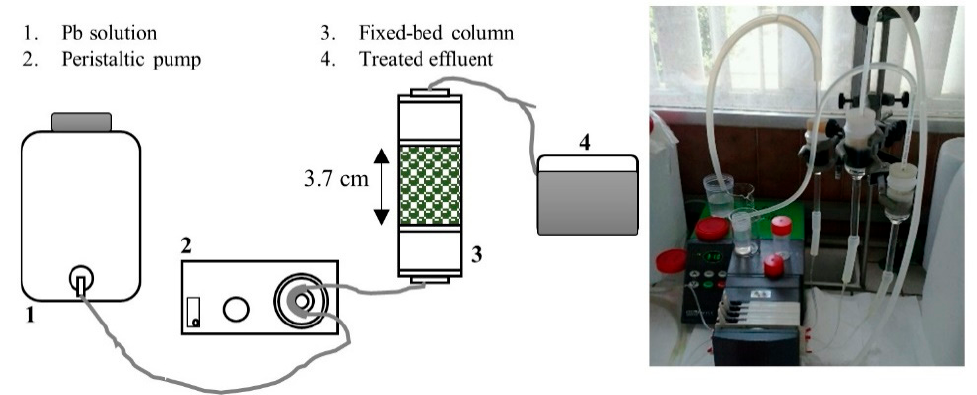
Figure 1. Setup of the experimental system.